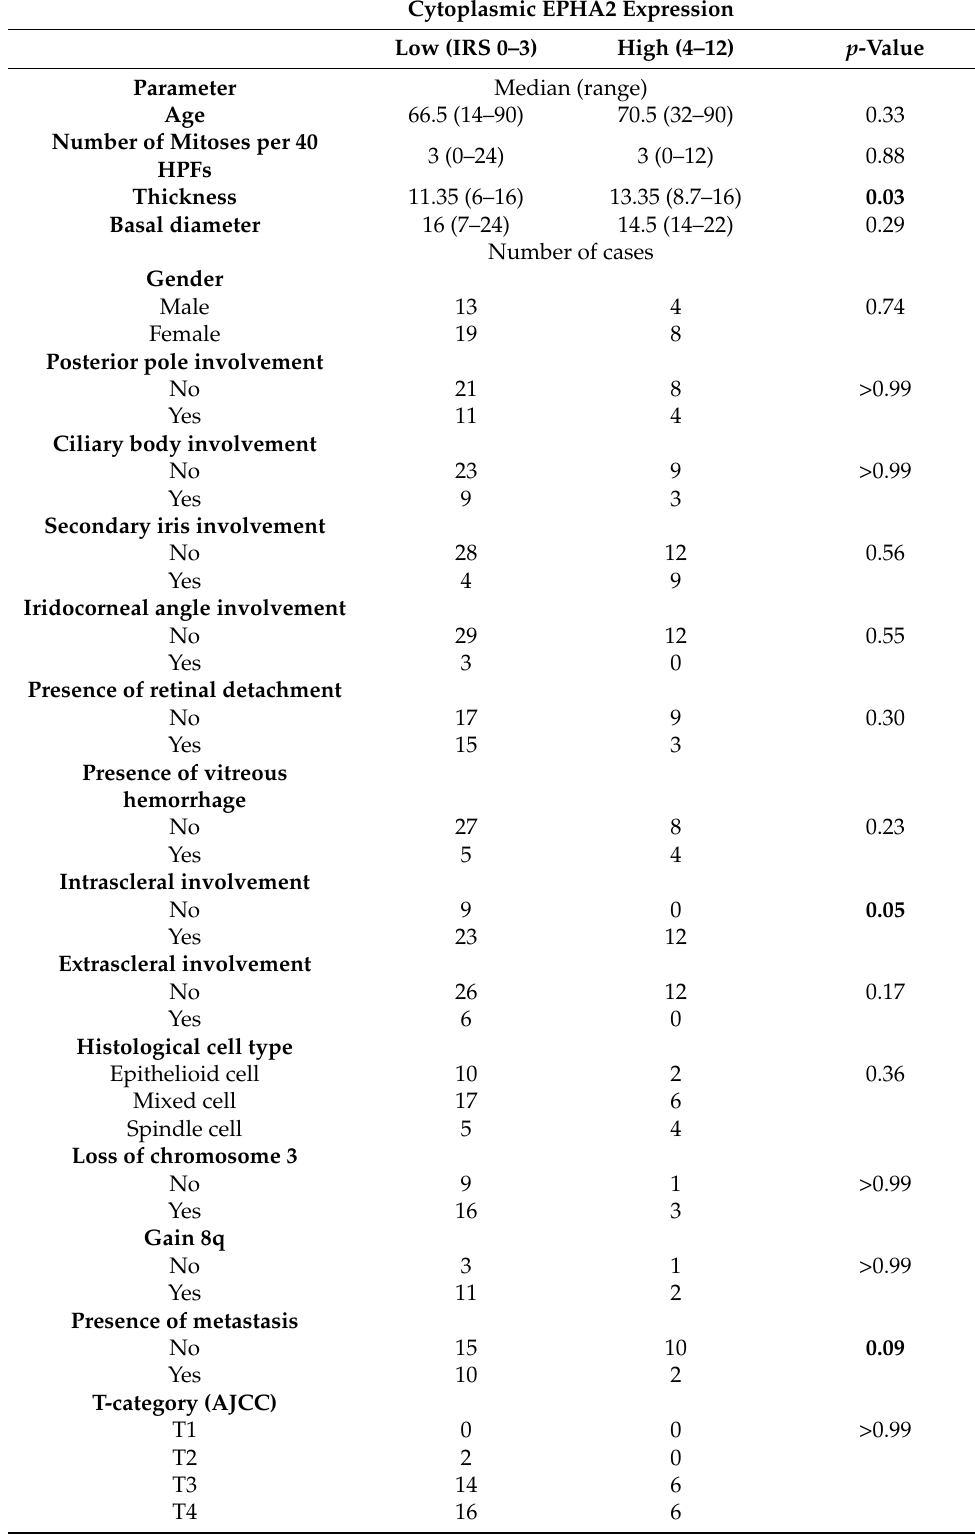
Table 2. Associations of EPHA2 with clinicopathological parameters. Cases that were completely negative for EPHA2 expression were classified in the low IRS